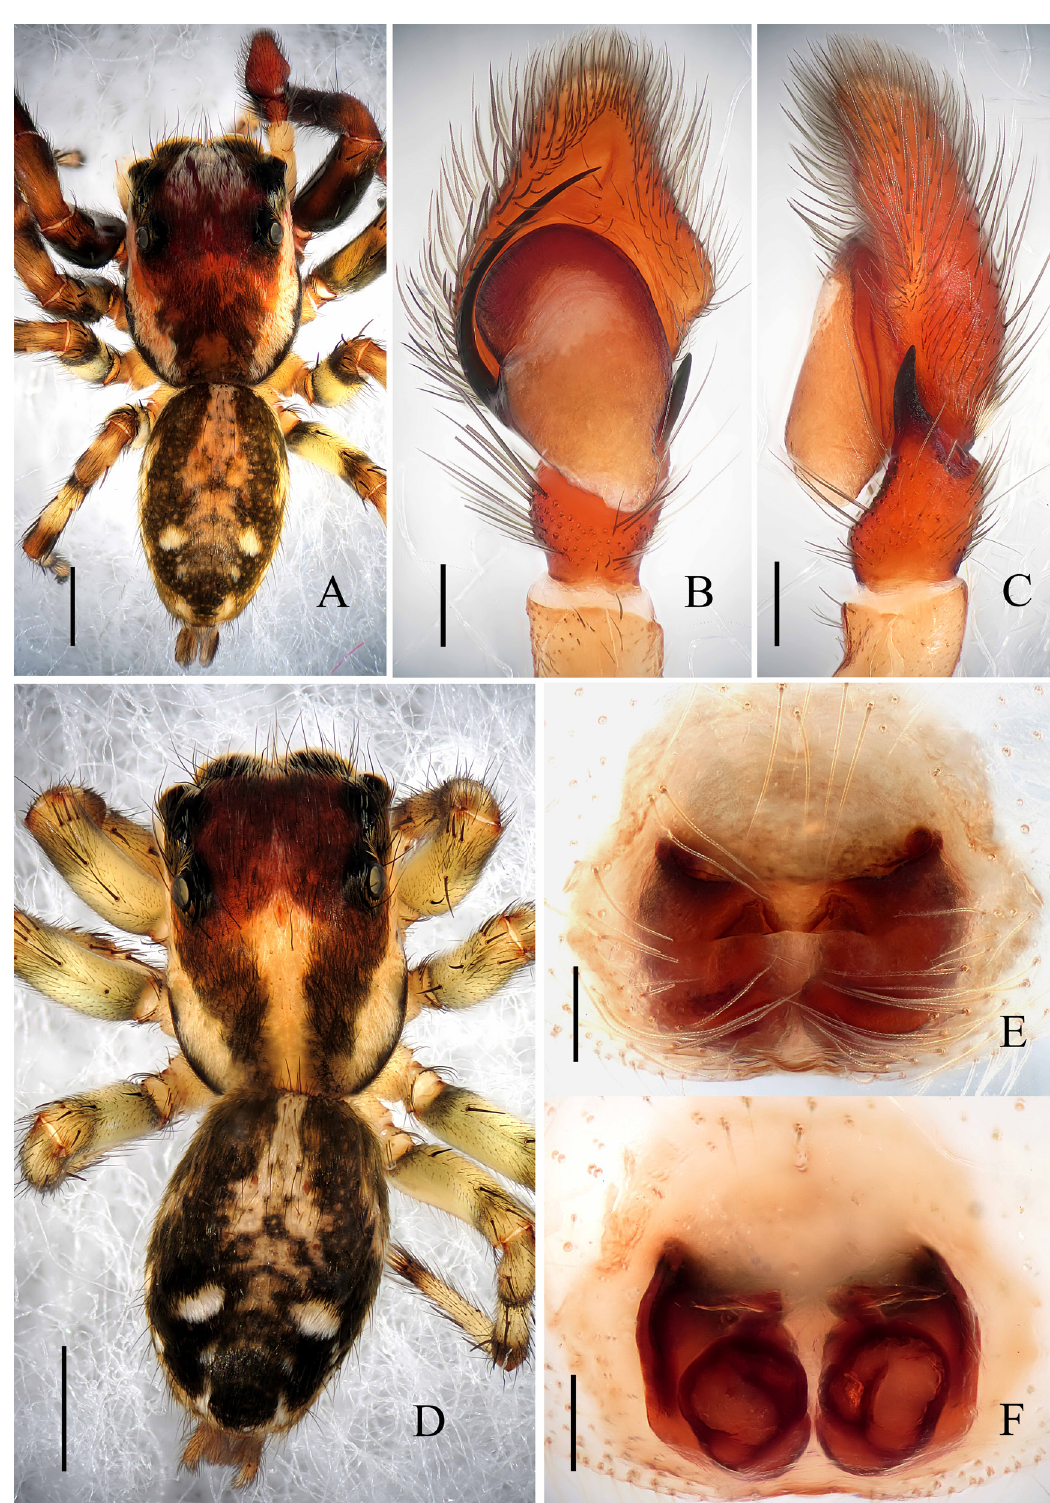
Fig. 1. Yaginumaella pulchella sp. nov. A – C . Holotype, ♂ (HNU-HN-IV-1417-02). D – F . Paratype, ♀ (HNU-HN-IV-1417-02). A . Male body, dorsal view. B . Male palp, ventral view. C . Male palp, retrolateral view. D . Female body, dorsal view. E . Epigyne, ventral view. F . Vulva, dorsal view. Scale bars: A, D = 1 mm; B–C, E–F = 0.2